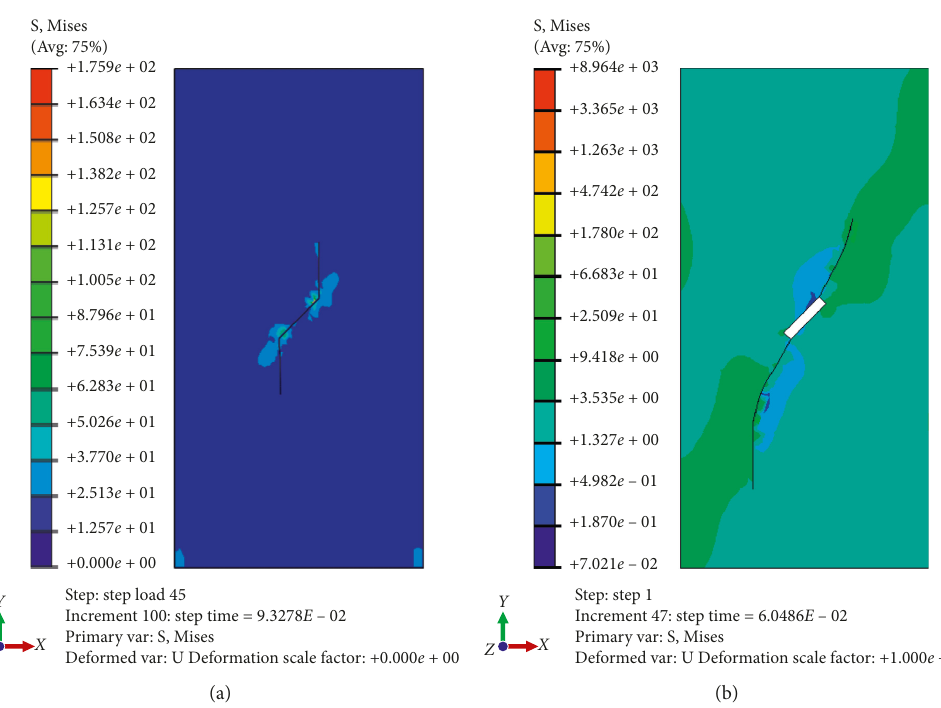
Figure 7: Numerical simulation results of single-crack fracture propagation with β � 45 ° : (a) 0.5mm thick crack ( ρ � 0.25mm); (b) 2.0mm thick crack ( ρ � 1.0mm).